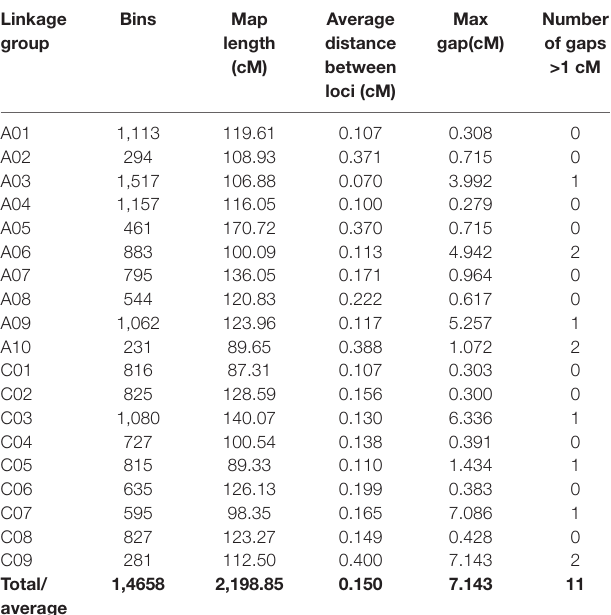
TaBLe 3 | Construction of a high-dense B. napus genetic map. Linkage group